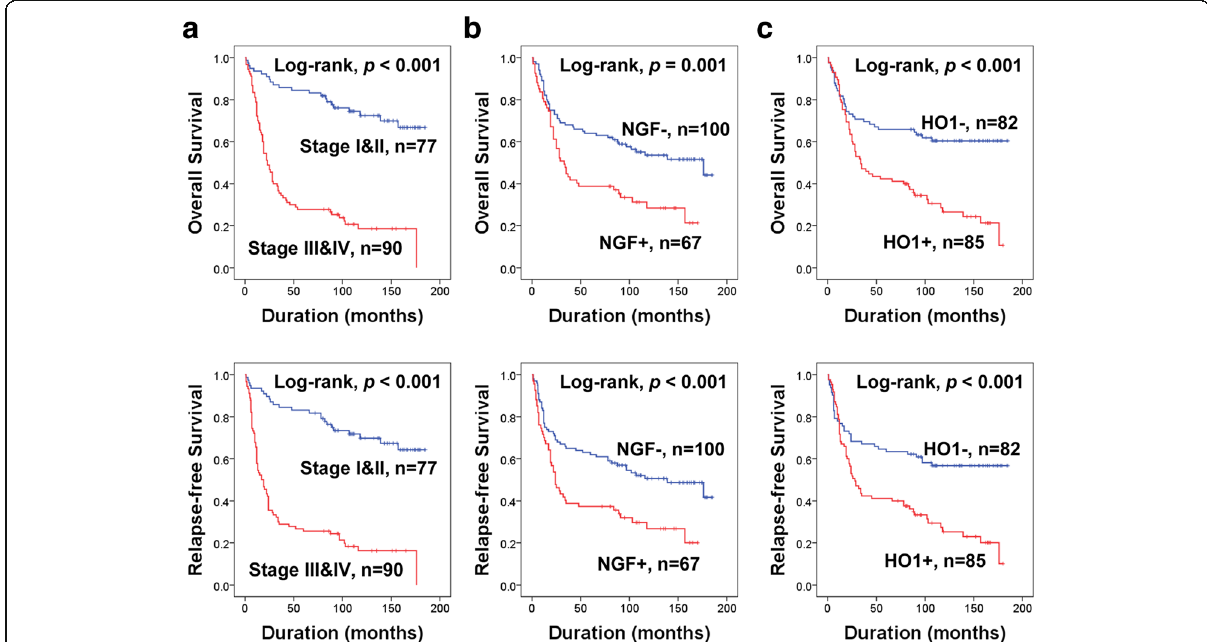
Fig. 2 Kaplan-Meier survival analysis in 167 gastric carcinomas. The survival curves according to the tumor stage ( a ) and the expression of NGF ( b ) and HO1 ( c )